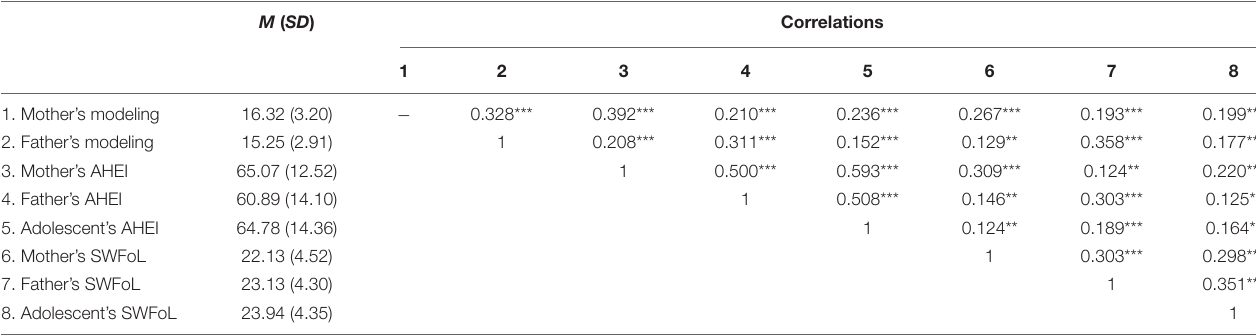
TABLE 2 | Descriptive statistics and correlations for both parent’s modeling and the three family members’ diet quality (measured by the Adapted Healthy Eating Index, AHEI) and Satisfaction with Food-related Life (SWFoL) in dual-earner parents with adolescent children ( n = 430). M ( SD